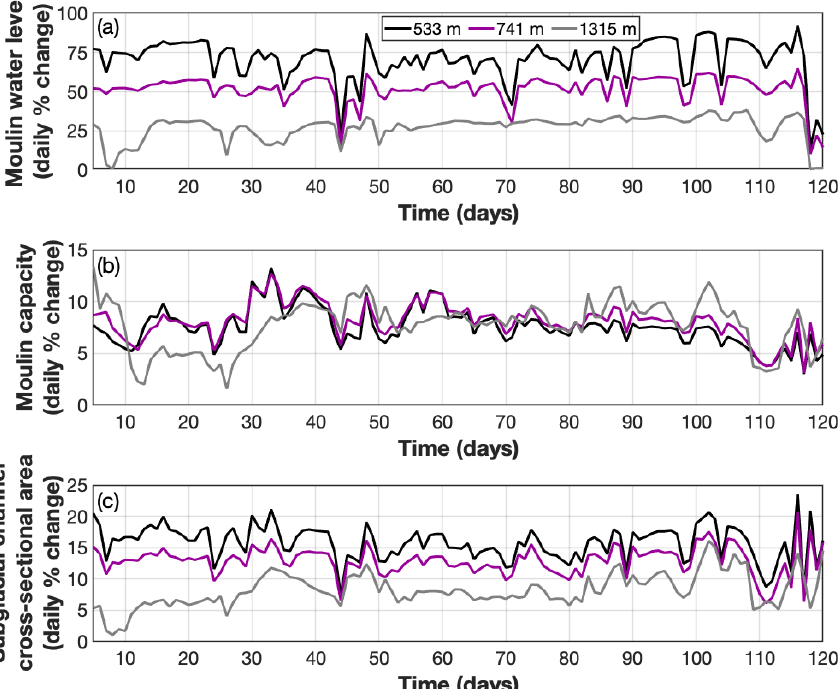
Figure 9. Daily percentage change in moulin variables relative to the daily mean value. (a) Daily percentage change in moulin water level relative to the daily mean water level for Basins 1, 2, and 3 (black, purple, and grey lines, respectively). (b) Daily percentage change in moulin capacity relative to the daily mean moulin capacity. (c) Daily percentage change in the subglacial channel cross-sectional area relative to the daily mean value. For (b) and (c) , colors are as in (a)